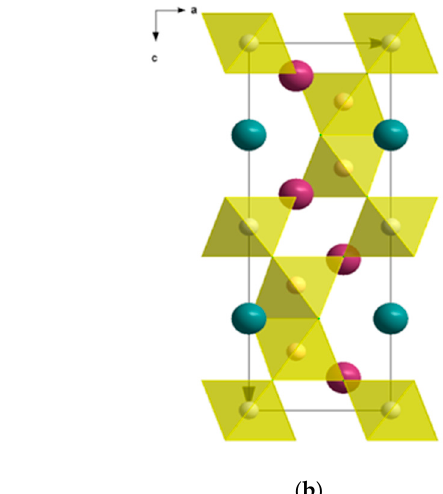
Figure 13. Crystal structure of CsCdBr 3 : ( a ) the xy projection with polyhedra for the Cs atoms; ( b ) the xz projection with polyhedra for the Cd atoms.